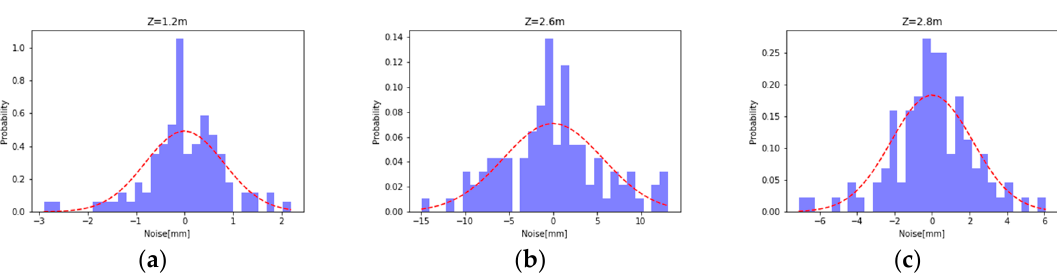
Figure 9. ( a ) Z = 1.2 m deviation distribution; ( b ) Z = 2.6 m deviation distribution; and ( c ) Z = 2.8 m deviation distribution.